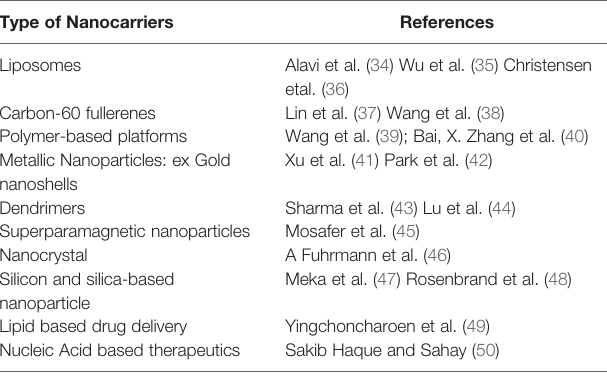
TABLE 2 | Different types of